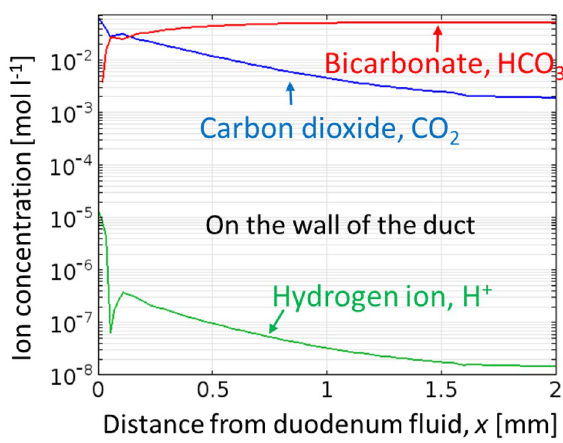
Figure 2. Simulated concentrations of carbon dioxide (blue), hydrogen ion (green), and bicarbonate (red) on the wall of hepato-pancreatic duct. Simulated pH increased greatly between the duodenal fluid and the pancreatic duct (green) since hydrogen ions (green) were neutralized by bicarbonate (red) with carbon dioxide as a byproduct (blue). Simulated ion concentration distribution in the hepatopancreatic duct of healthy individuals. Ion concentrations at a ductal radius of 2.6 mm pH = − log 10 ( [ H + ] ) .